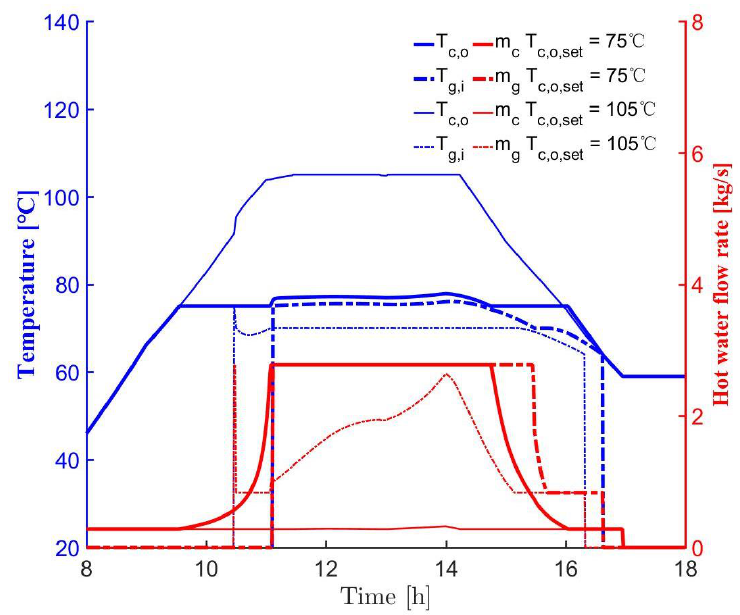
Figure 9. Hot water temperature and flow rate for different Tc , o , set